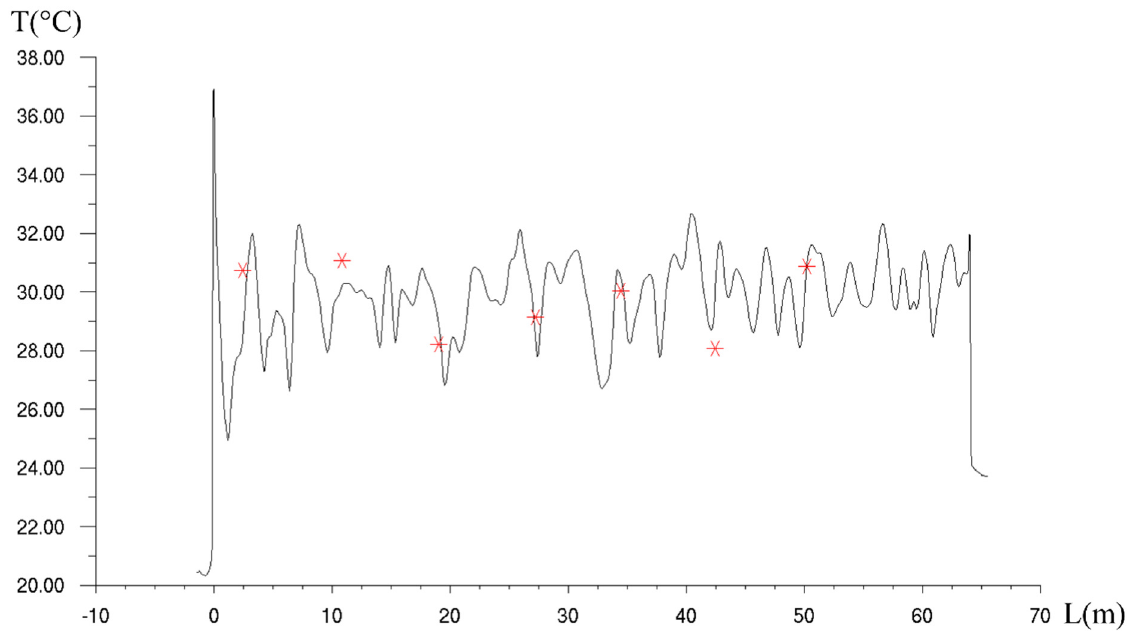
Figure 4. Measured (*) and simulated (---) temperature profiles along the greenhouse length (from SW to NE) at the height of 1.34 m in the middle of the greenhouse width (x = 4.3 m).